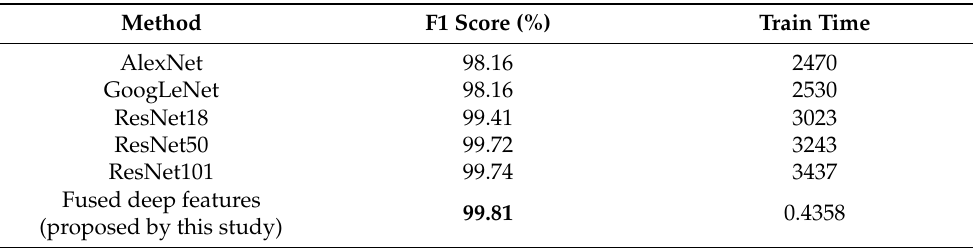
Table 10. Performance comparison between the proposed method and using CNN network directly (bold font shows the best